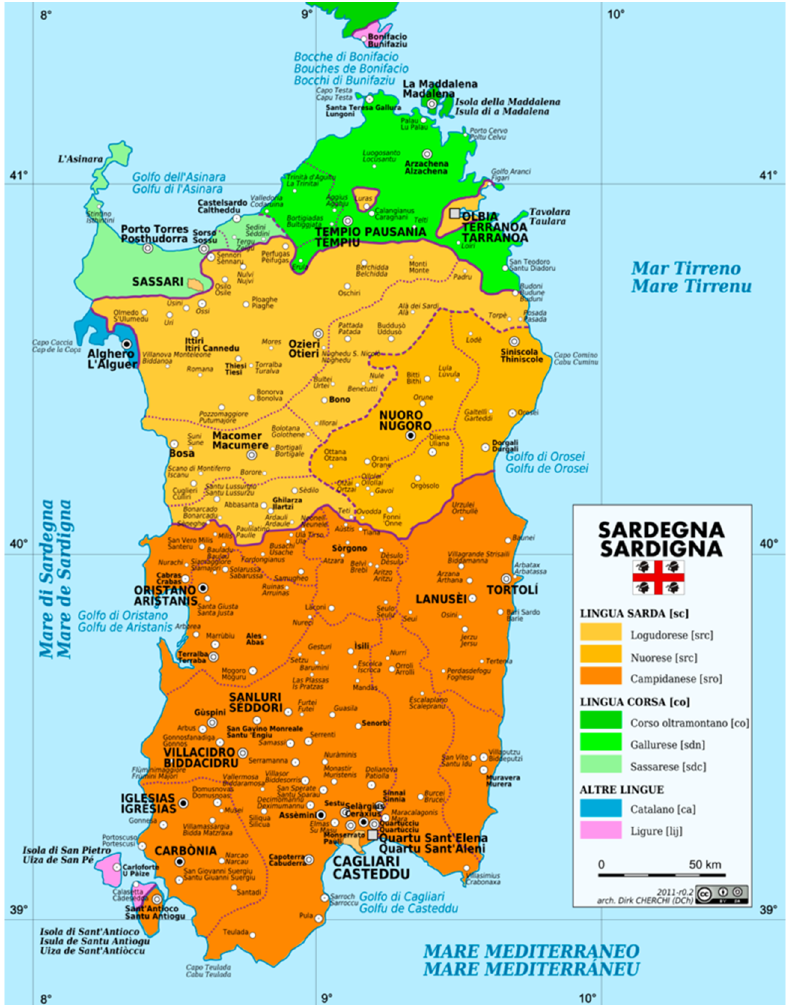
Figure 5. Language varieties spoken in Sardinia (‘Sardinia Language Map’ by Dch 2009/Wikimedia Commons is released under CC BY-SA 3.0).